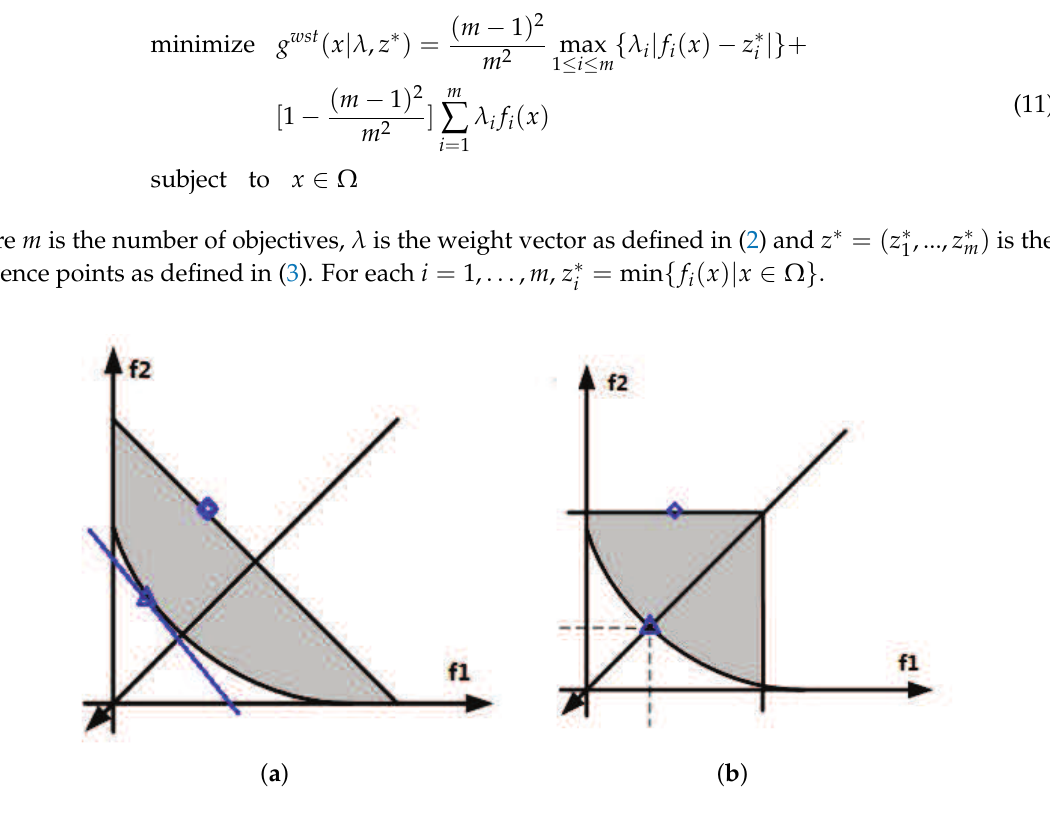
Figure 1. Illustration of the improvement regions for the ( a ) weighted sum approach and the ( b ) weighted Tchebycheff